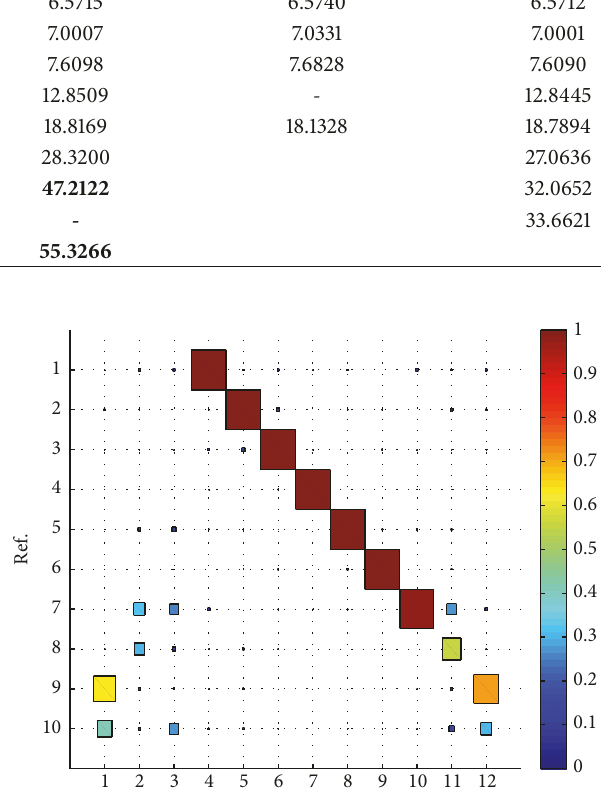
Figure 3: MAC analysis between accurate shapes and shapes from DCB